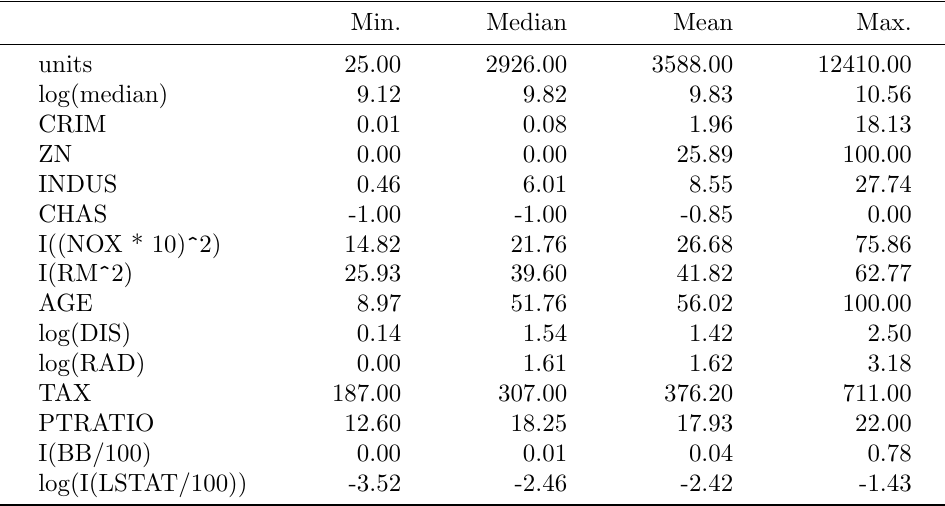
Table A.3: Descriptives for variables included in the hedonic house value regression; 96 approximate TASSIM zones